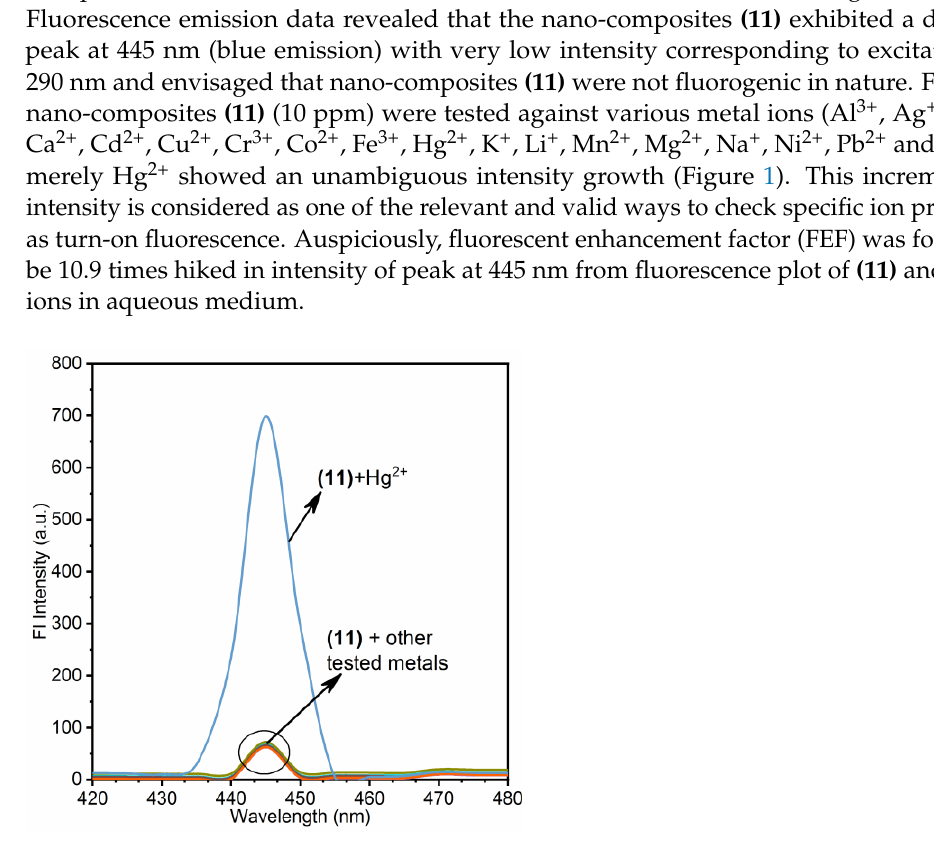
Figure 1. Fluorescence response of (11) (10 ppm) towards various cations at excitation of 290 nm. Whereas, emission profile of nano-composites (12) was also recorded as a free sensor with excitation wavelength of 290 nm. Emission spectral analysis of the nano-composites